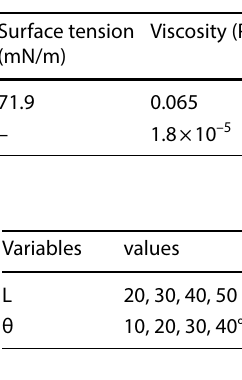
Table 2 The properties of the liquid and gas